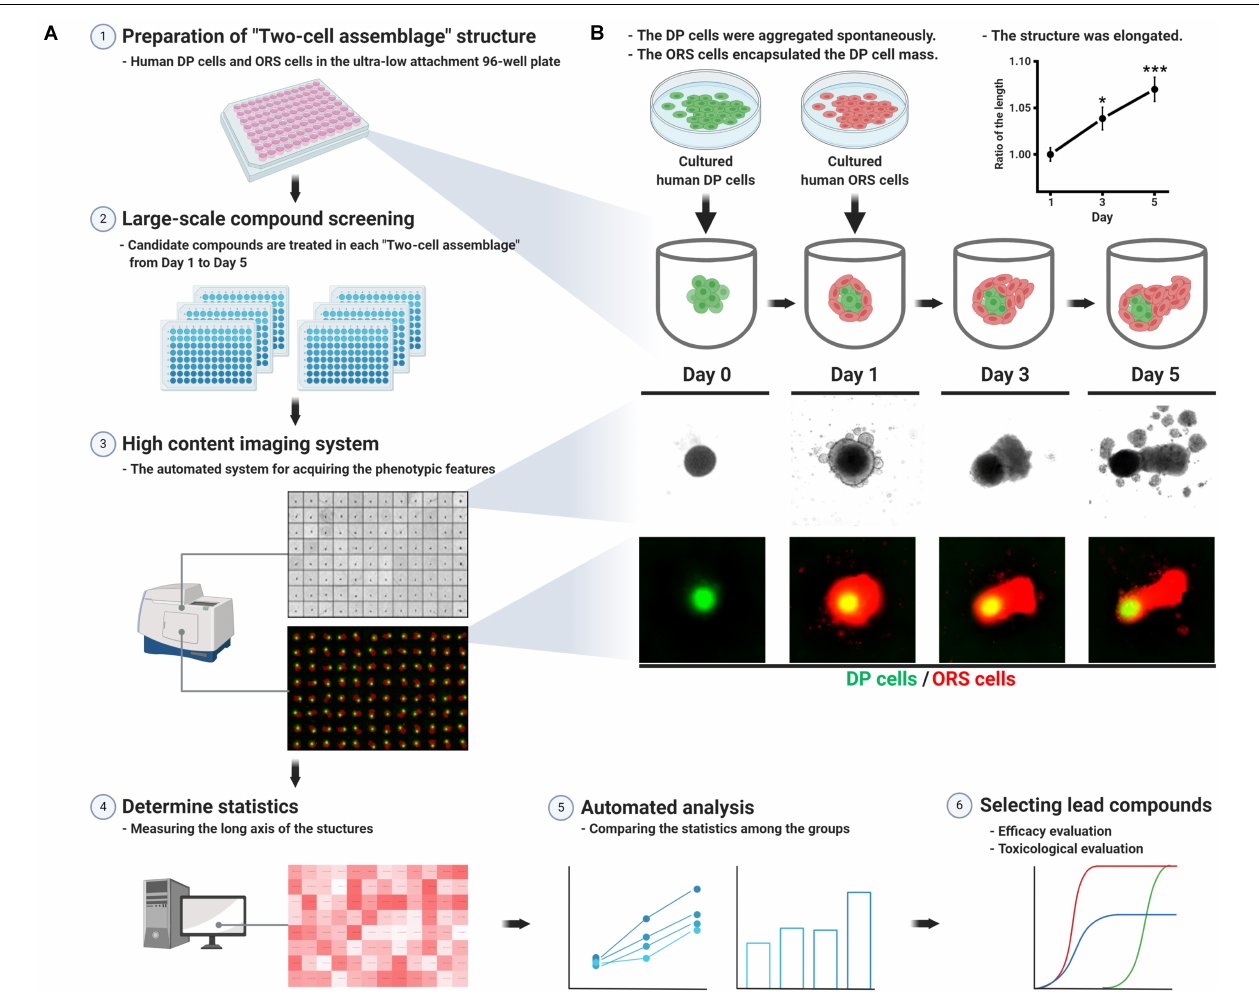
FIGURE 1 | Schematic work flow for preparing the “two-cell assemblage (TCA)” structure and screening hair growth-promoting compounds. (A) Each TCA was loaded into each well of the ultra-low attachment 96-well plate, in which candidate compounds were treated for 5 days. The long axis length of the TCAs was acquired using a high content imaging system. The data for each candidate compound-treated group were compared to reveal the most effective compound, which would then require further evaluation. (B) Preparation of the TCA consisting of human dermal papilla (hDP) and human outer root sheath (hORS) cells, which was elongated for 5 days. The long axis length was measured without any treatment and compared with the culture day time points (right upper panel, data are presented as mean ± SEM and were evaluated using one-way analysis of variance with Tukey’s multiple comparisons test. * p < 0.05 or *** p < 0.001, compared to day